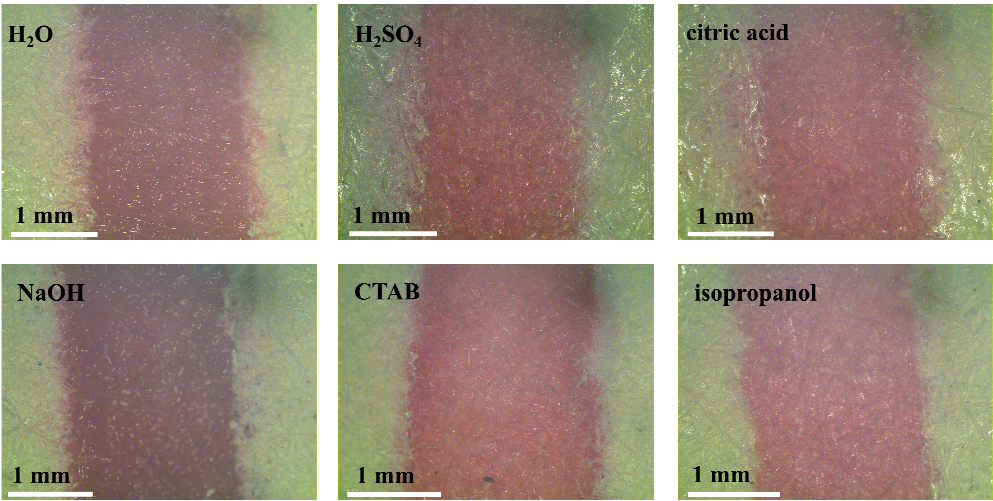
Figure 6. The optical micrographs of the lacquer barrier in the presence of different solutions.